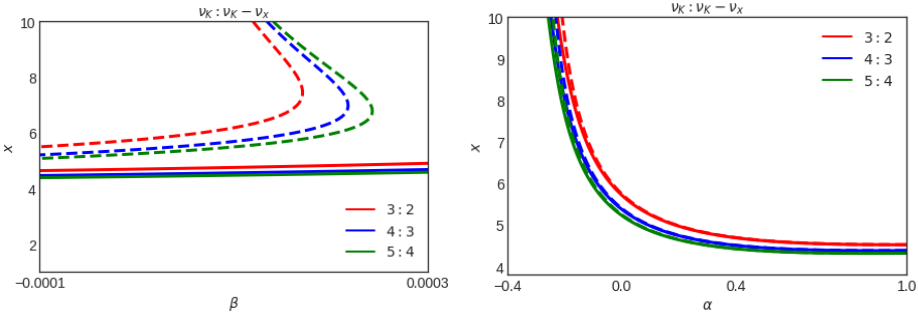
Figure 11. The first panel shows the location of three epicyclic resonances between the Keplerian epicyclic frequency and the periastron frequency as a function of β . The thick line represents α = 0.4 and the dashed line α = 0. The second one shows the location of three epicyclic resonances between the Keplerian epicyclic frequency and the periastron frequency as a function of α . The thick line represents β = − 0.00001 and the dashed line β =